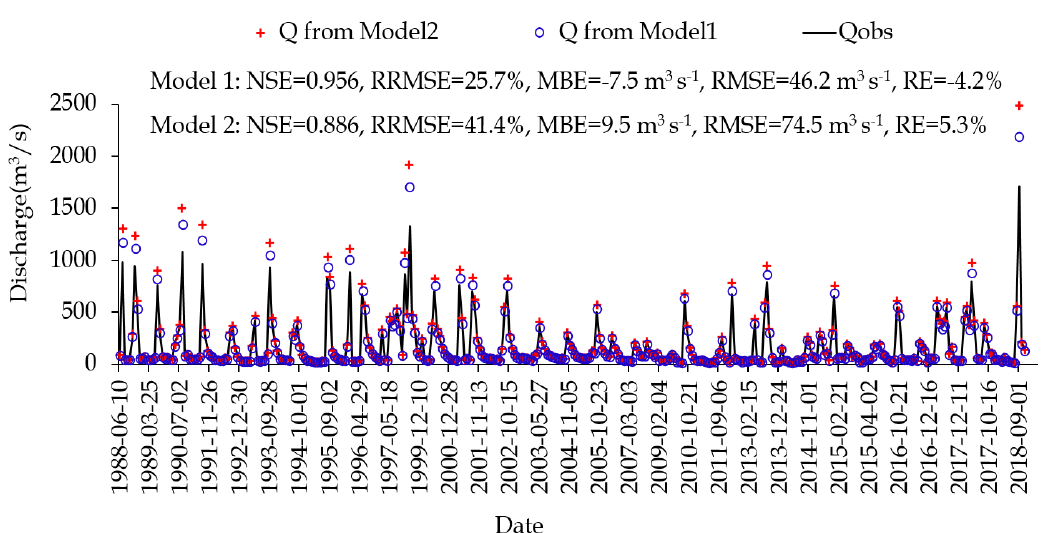
Figure 9. A time series plot of observed and estimated (via Model 1 and Model 2) discharge at Lhasa gauge over the study period of 1988–2018. Both models tend to overestimate discharge at moderate and high flows and underestimate discharge at low flows, but in general both models consistently capture the temporal changes.